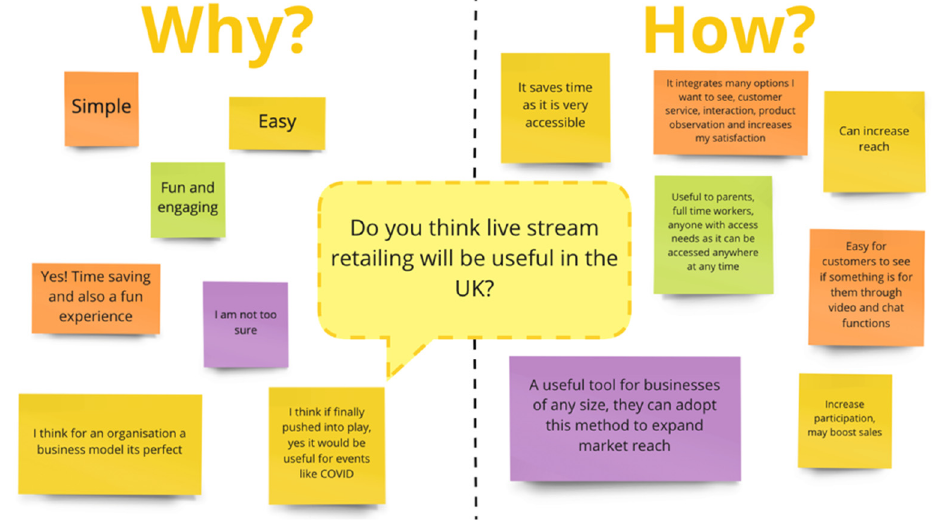
Figure 8. A screenshot from the Participatory Design workshop Miro board, illustrating why and how live stream retailing is useful.